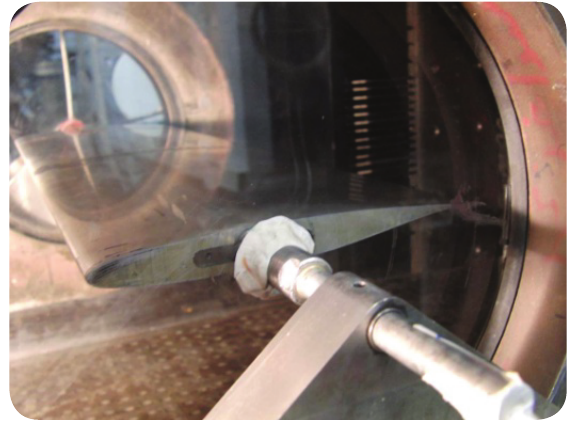
Figure 4. Airfoil, rake and sensors fixed in the test